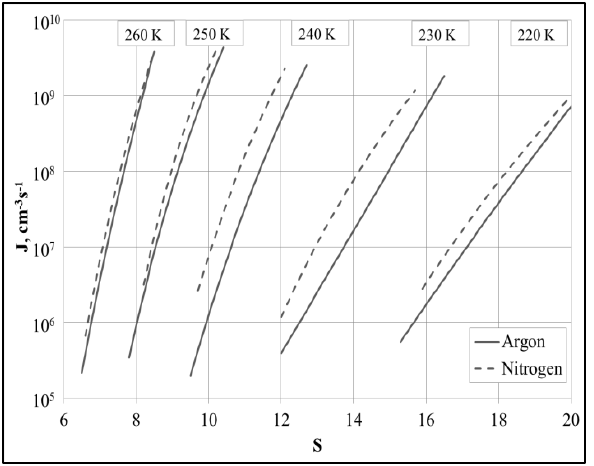
Fig. 6 . Comparison of water nucleation experimental data with different carrier